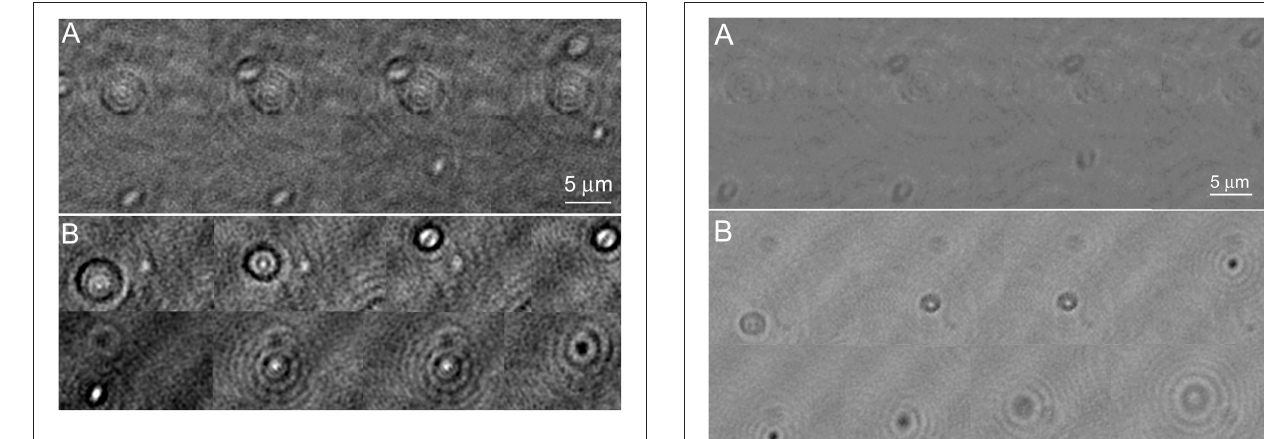
FIGURE 3 | Amplitude images of Vibrio alginolyticus swimming through x, y, and z. Images show a time series in a single z-plane with a cell coming into/going out of focus as it swims. The images are successive frames recorded at 7 frames per second, or 0.14s between frames. (A) No dye. (B) Labeled with NanoOrange.